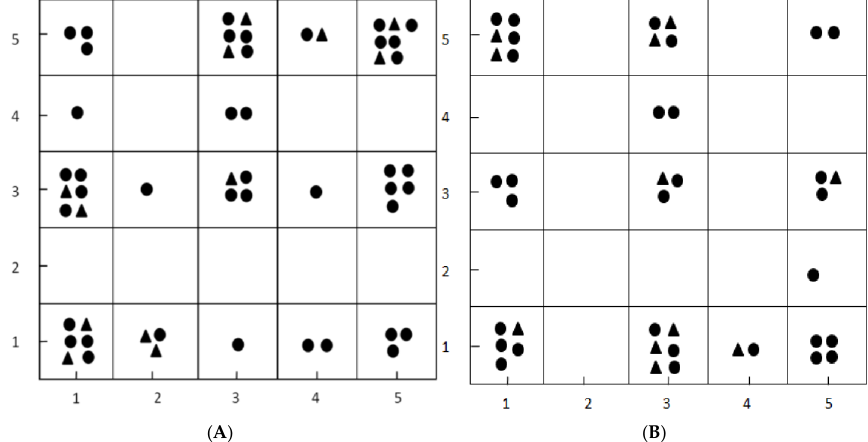
Figure 1. The Kohonen maps for the training set and test set for LXRβ modeling ( A ) and LXRα modeling ( B ): black dots represent compounds of the training set and black triangles represent compounds of the test set.